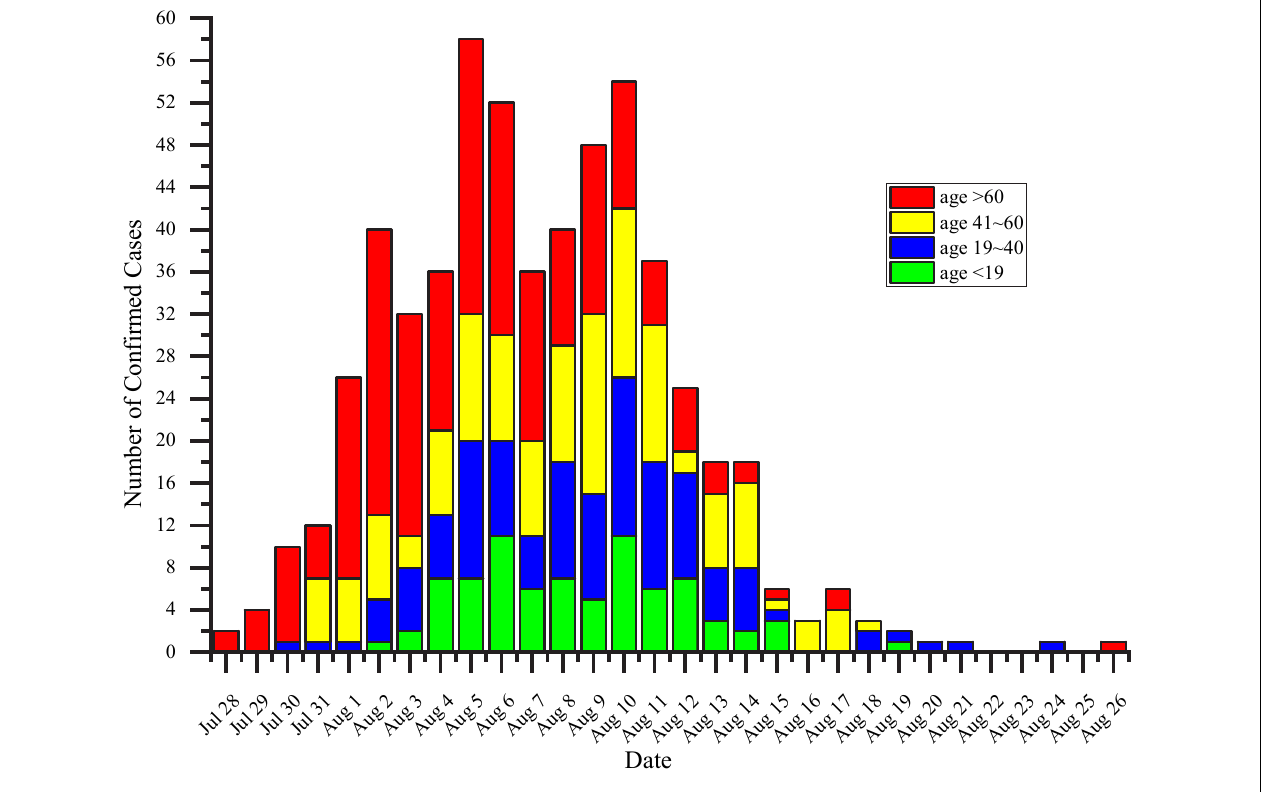
FIGURE 2 | Quantitative visualization of the daily diagnostic number of COVID-19 in Yangzhou, China. The compositions of confirmed cases in different age groups were characterized by cumulative bars in different colors. Green bar: < 19 years old. Blue bar: between 19 and 40 years old. Yellow bar: between 41 and 60 years old. Red bar: > 60 years old.